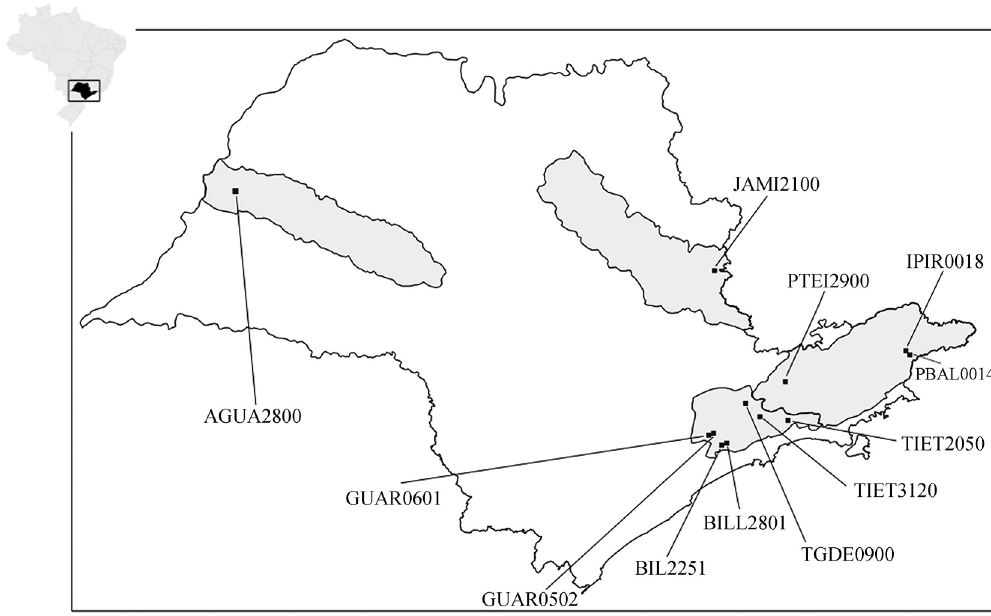
Figure 1 - Locations of sampling sites in the WMU (grey